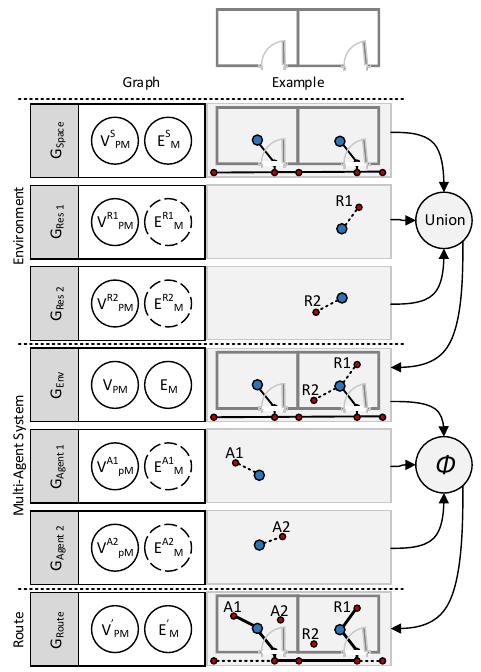
Figure 10. Representation of indoor space as a network. The large blue circles represent locations indoors, they reference general placement. The smaller red circles represent positions or places, and reference specific placement.